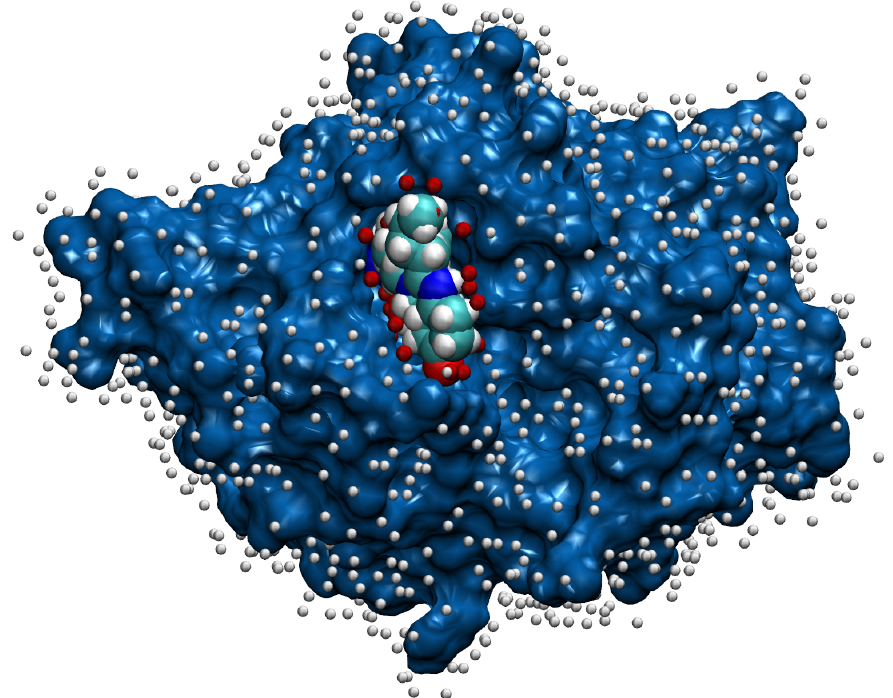
Figure 4. The surface of chain A for the PDB file 1a8t [34,35] is painted blue, and the bound ligand that represents its elements has default colors. The white balls close to the surface denote non-ligandable points, and the red balls denote ligandable points. For the representation, we used the VMD [26] software.